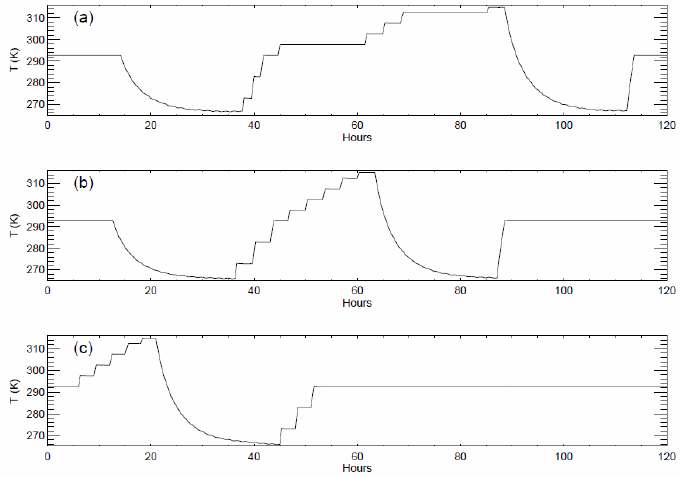
Figure 12. Blackbody temperature profiles during warm-up and cool-down (WUCD) calibration activities: ( a ) 6 February 2012 (first WUCD); ( b ) 22 May 2012 (second WUCD); and ( c ) 10 September 2012 (third WUCD).